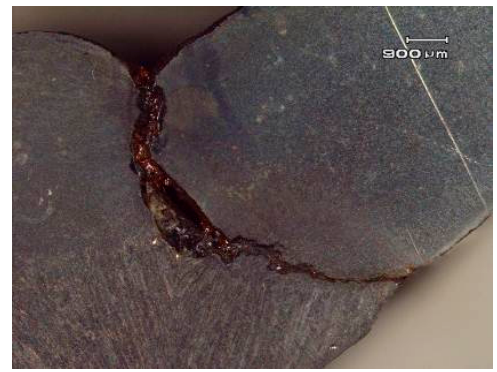
Figure 1. Lack of fusion and crack defects of welding.